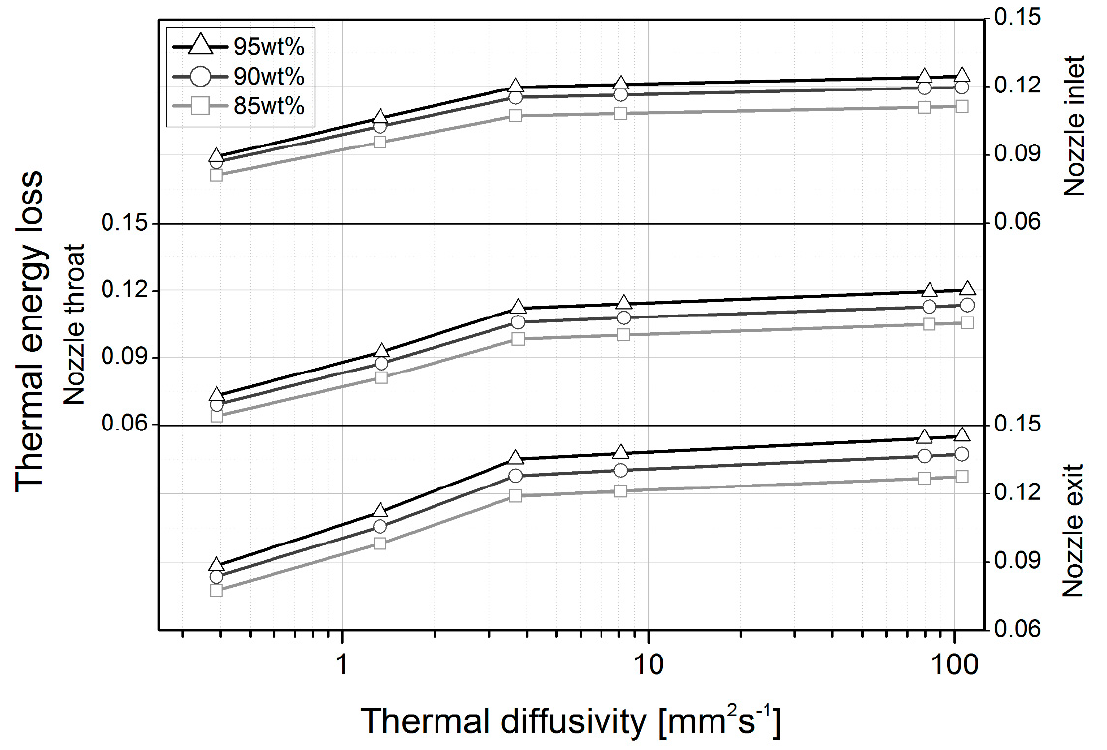
Figure 7. Thermal energy loss across the microthruster with materials of different levels of thermal diffusivity and different propellant enthalpies (85, 90, and 95 wt% hydrogen peroxide).